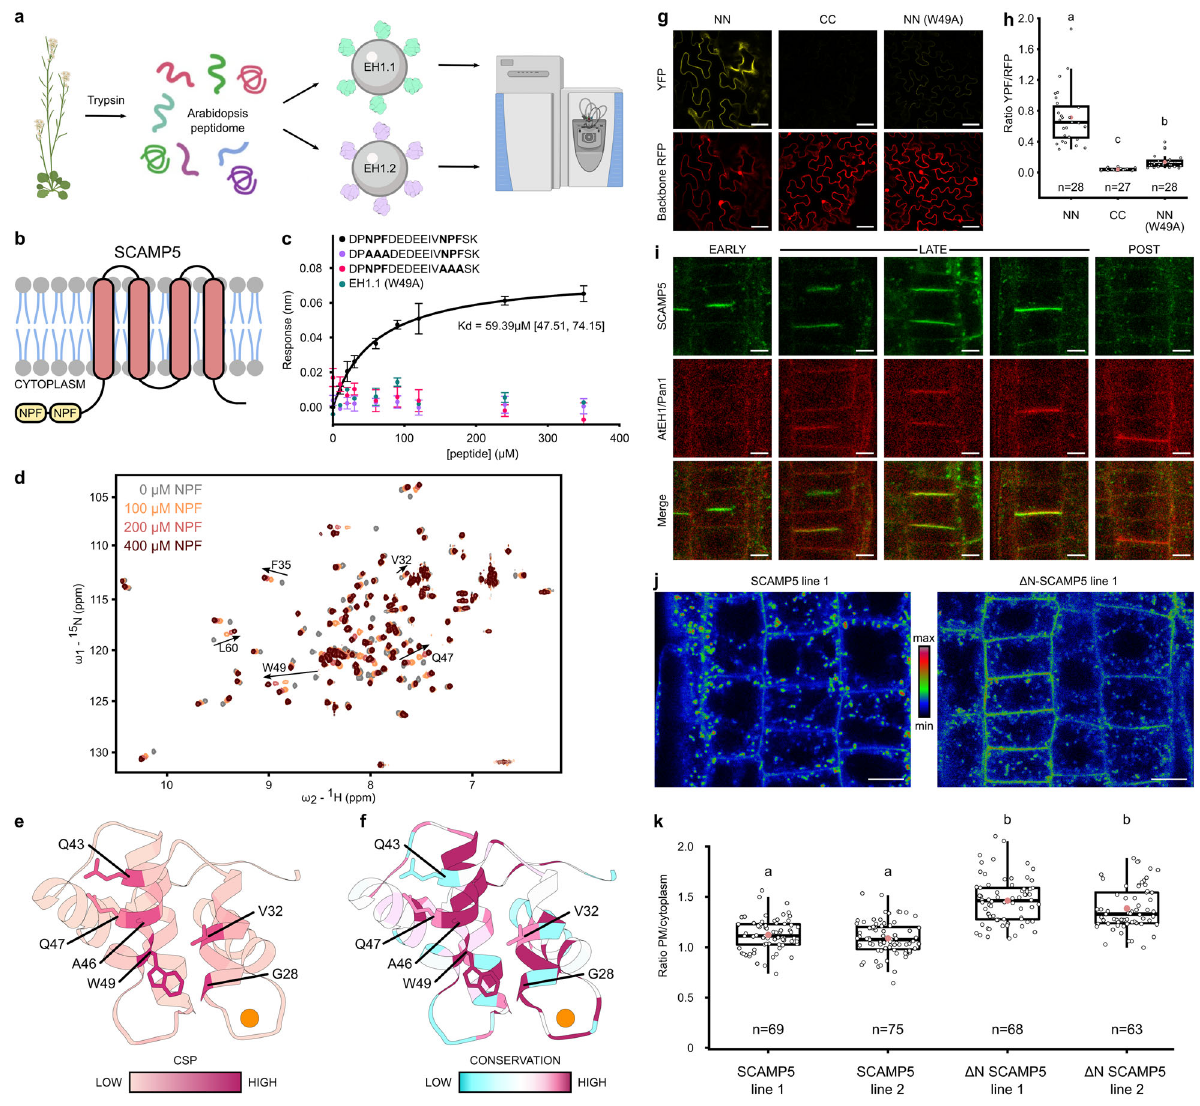
NPF peptide of SCAMP5 was identi fi ed as a signi fi cant interactor of EH1.1 (Fig. 3b, Supplementary Data 3). This peptide also